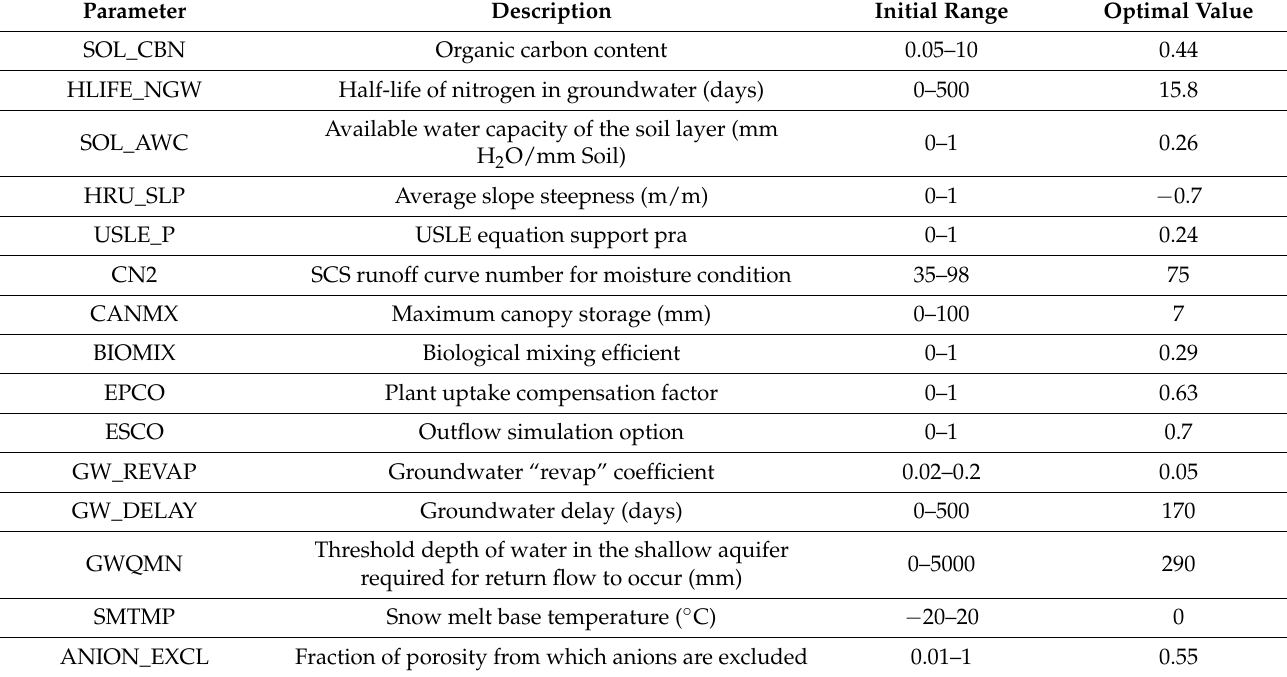
Table 2. Parameters adjusted in the calibration of Soil and Water Assessment Tool